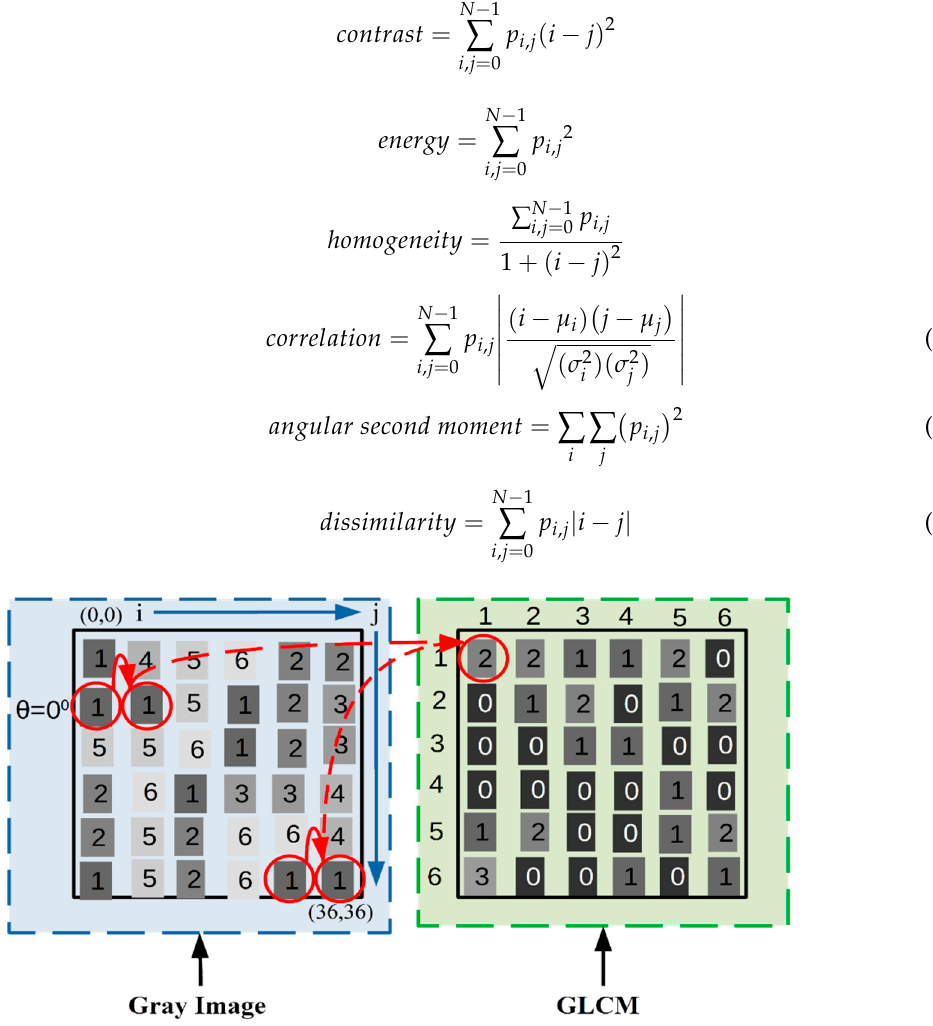
Figure 4. The creation of the gray level co-occurrence matrix (GLCM) that describes the frequent occurrence of the gray level values at zero degrees. In addition to the GLCM features, the LBP feature was also used as an additional textural feature. The LBP is used in many applications such as face recognition and texture analysis [25,26]. The basic concept of the LBP is to convert the gray level image into a set of labels. The labels are constructed by creating a binary image by taking the threshold value from a center pixel point against a set of neighboring pixels, usually 3 × 3 pixels, then converting the binary values into a decimal gray level representation [25]. Figure 7 shows the conversion steps of the LBP